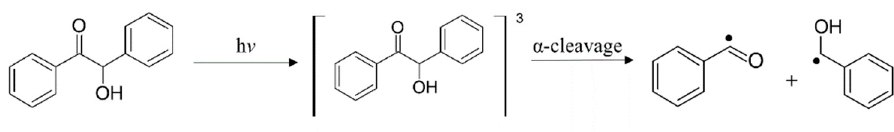
Figure 15. Type II photoinitiation mechanism [164]. Copyright © 2022 ACS.